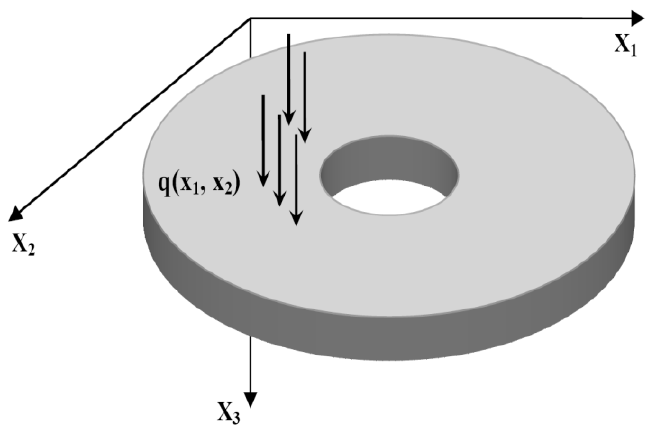
Fig. 1. An annular plate in